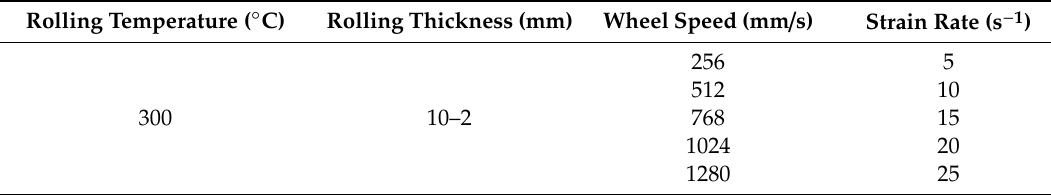
Table 1. The HSRR process at different strain rates.